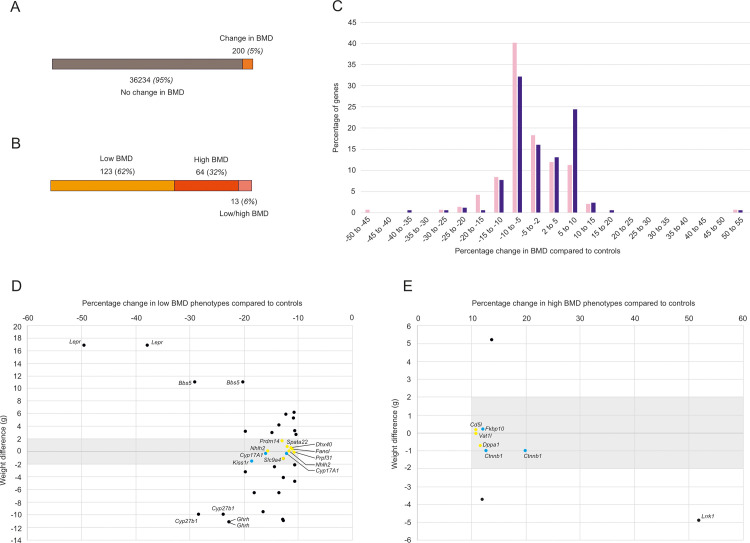
Mouse phenotyping identified 200 BMD genes.(A) Of the 3,823 genes deleted in mice, 200 or 5% caused a change in BMD phenotype. (B) Directional changes in BMD. Low and high BMD was found after deletion of 123 and 64 genes, respectively. Another 13 genes caused low or high BMD dependent on sex. (C) Percentage change in BMD compared to wt animals. In both male (blue bars) and female (pink bars) mice, most BMD genes reduced BMD between 5% and 10%. Changes between -2% and +2% were not plotted as these were not considered by PhenStat as significant phenotypes. (D) and (E) A limited weight difference compared to wt controls in combination with a greater than 10% decrease or increase in BMD change prioritized (gray shaded areas) genes for further investigation. Genes with a greater than 10% decrease (D) or increase (E) in BMD were plotted separately, and genes affecting female or male mice represented individually. Priority genes in the gray shaded areas were colored yellow or blue according to class 1 or 2, respectively. For clarity, outside the gray sectors, only genes associated with greater than 20% decrease (D) or increases (E) in BMD were name tagged.